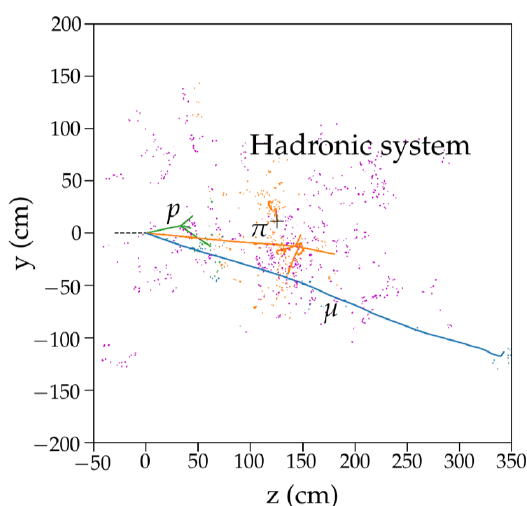
Figure 21.1: An example simulated 4 GeV ν µ event using GENIE and FLUKA. The magenta energy deposits are caused by neutrons undergoing multiple scatterings; the orange color denotes energy originally carried by the prompt charged pion. The figure is taken from Ref. [ 375 ]